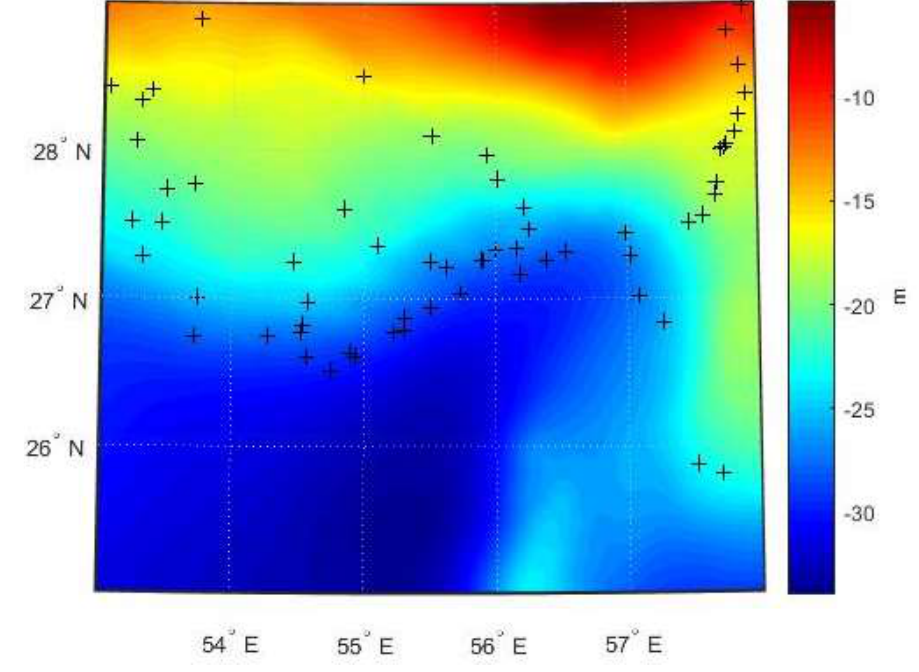
Figure 8. The gravimetric geoidal heights, the cross signs represent the location of the GNSS/levelling control points (m). Table 4. The statistics of the geoidal height test at the GNSS/levelling points.